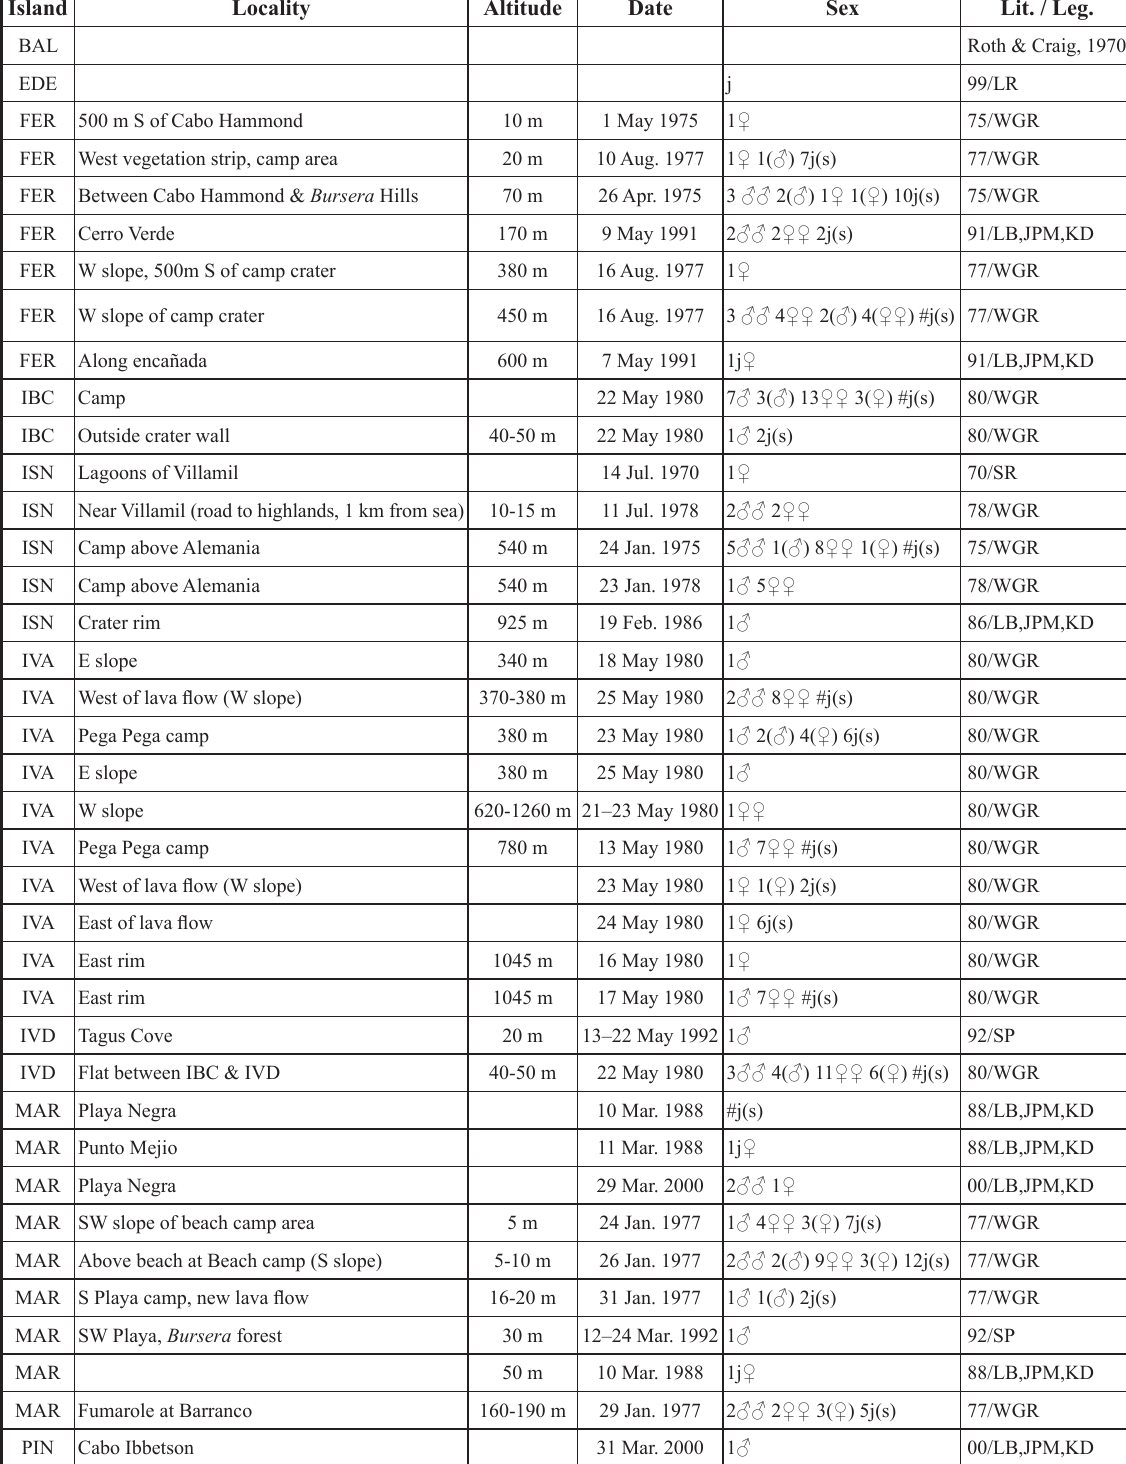
Table 1. Other material examined of Eustala occidentalis sp. nov. abbreviations: BaL: Baltra, eDe: eden, Fer: Fernandina, IBC: Isabela, Beagle Crater, ISN: Isabela, Sierra Negra, IVa: Isabela, Volcán alcedo, IVD: Isabela, Volcán Darwin, Mar: Marchena, PIN: Pinta, PIz: Pinzón, raB: rábida, SaN: Santiago, SEY: Seymour Norte, SPL: South Plaza; ♂: male, (♂): subadult male,♀: female, (♀): subadult female, j(s): juvenile(s), #: